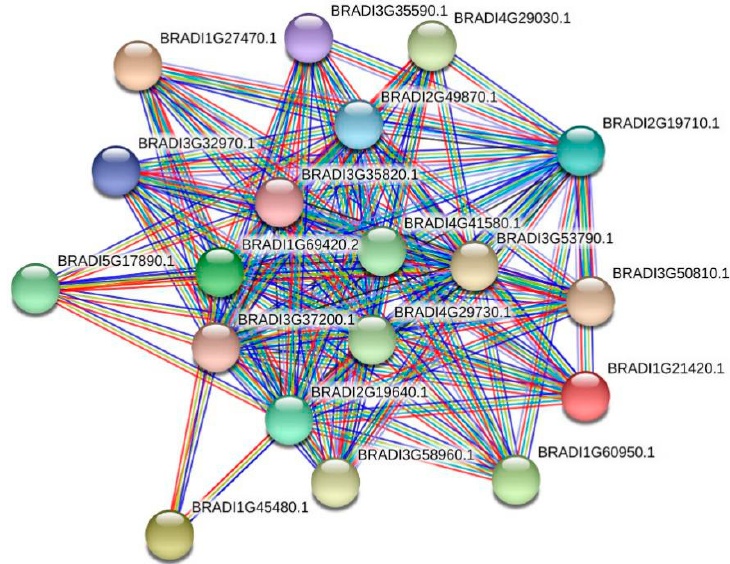
Figure 6. The interaction network between members of the family. Protein interaction network prediction showed that most BdTPS and BdTPP proteins interact with more than one other family member. Line colors represent the various types of evidence used to predict the protein interaction network.